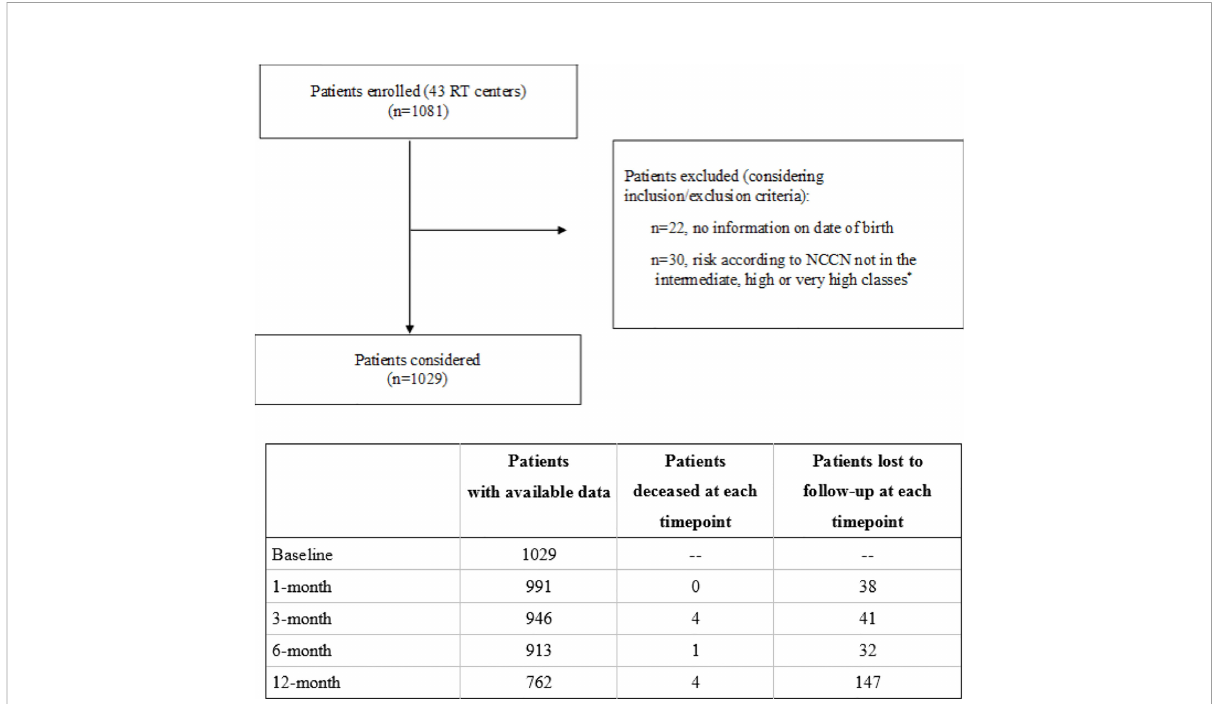
FIGURE 1 Flowchart of the PRO-EPI study. *Risk according to NCCN: intermediate (T2b, T2c, or Gleason score = 7 or 10 < PSA ≤ 20 ng/ml); high (T3a or Gleason score 8, 9, 10, or PSA > 20 ng/ml); very high (T3b, T4, or multiple risk factors for high